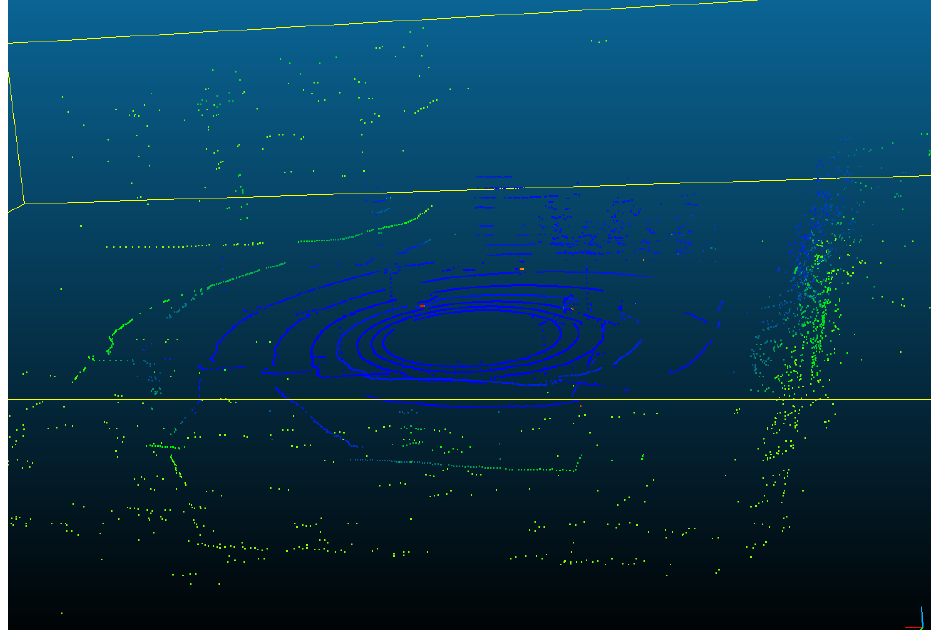
Figure 4. An example of 3D cloud points carried out through Velodyne VLP16 LiDAR. The coloring is related to the distance (depth) of the point from the